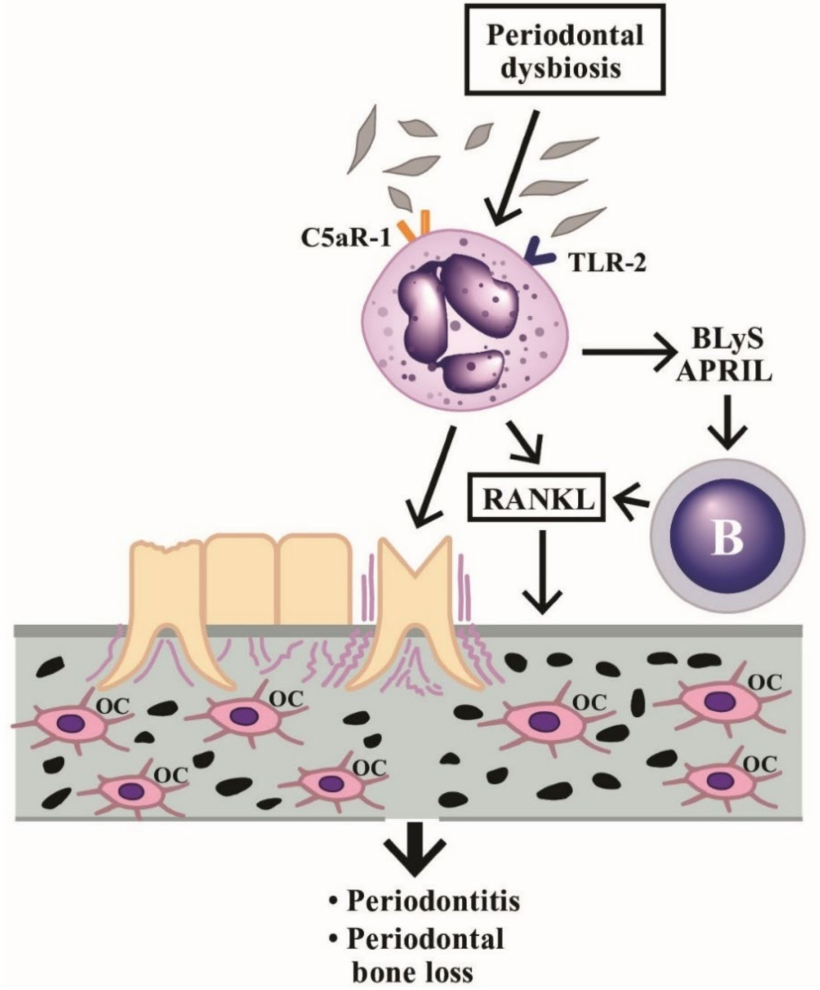
Figure 6. Induction of periodontitis and periodontal bone loss by PMNs initiated by periodontal dysbiosis. The periodontal dysbiotic bacteria bind to C5aR-1 and TLR-2 on PMNs. The binding stimulates BLyS and APRIL release from PMNs, which then activate B cells to produce RANKL. The RANkL binds to RANK receptors on macrophages to facilitate these cells differentiating to osteoclasts (OC). Finally, periodontitis and bone loss in the periodontal tissue occur. BLyS: B